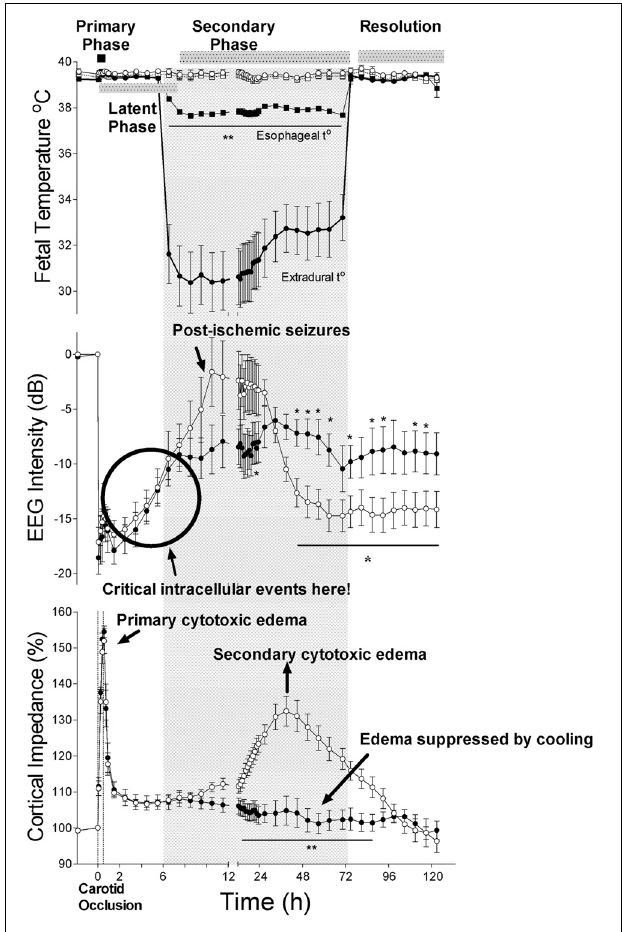
FIGURE 1 | The effects of 30min of cerebral ischemia (from t = 0, shown by vertical dotted lines) with or without induced mild hypothermia (shown by the bar) started 5.5h after reperfusion in near-term fetal sheep on fetal temperature, electroencephalographic (EEG) intensity and cortical impedance (a measure of cell swelling). The top panel shows changes in extradural (solid circles) and esophageal (solid squares) temperature in the hypothermia group and extradural (open circles) and esophageal (open squares) temperature in the normothermia group. The lower two panels show changes in EEG intensity (dB) and cortical impedance (expressed as percentage of baseline) in the hypothermia (solid circles) and normothermia (open circles) groups. The hypothermia group showed greater recovery of EEG intensity after resolution of delayed seizures and complete suppression of the secondary rise in impedance. Data modified from Gunn et al. (1998). ∗ p < 0 . 05; ∗∗ p < 0 . 001.